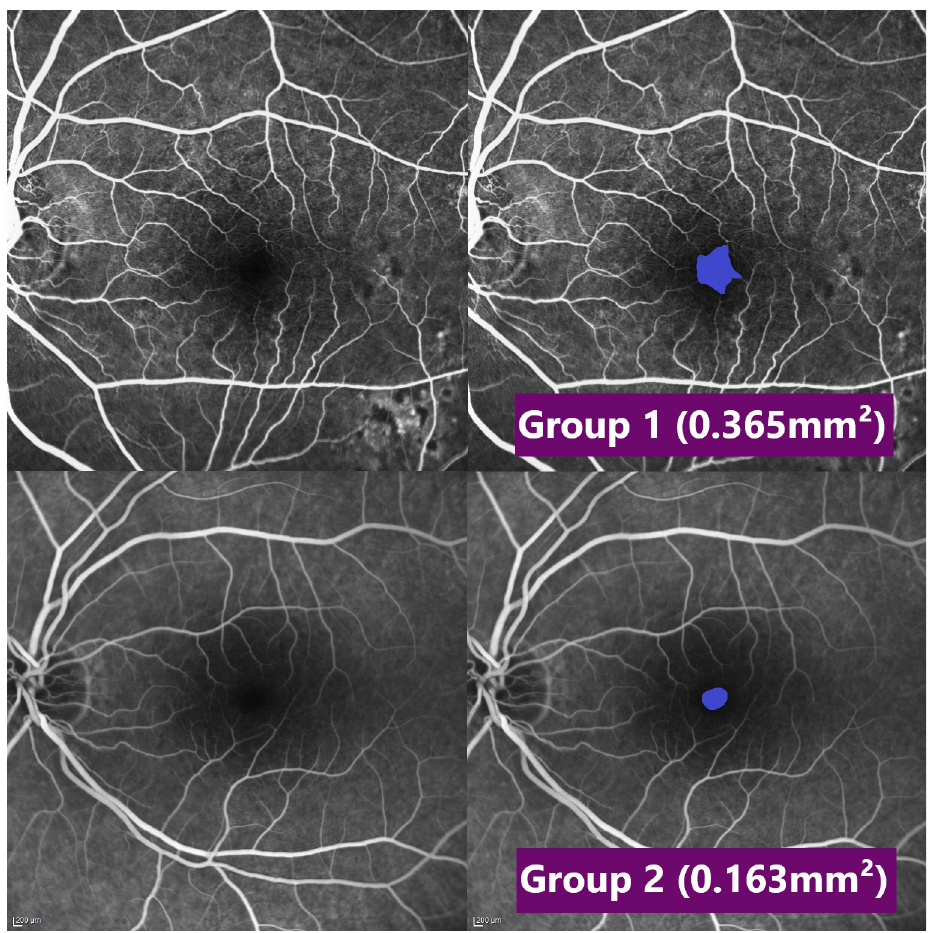
Fig 4. FAZ area. Exemplary early phase FA recordings of both groups from a matched pair without (left) and with (right) annotated FAZ area, showing a smaller FAZ area in the lower image (Group 2).